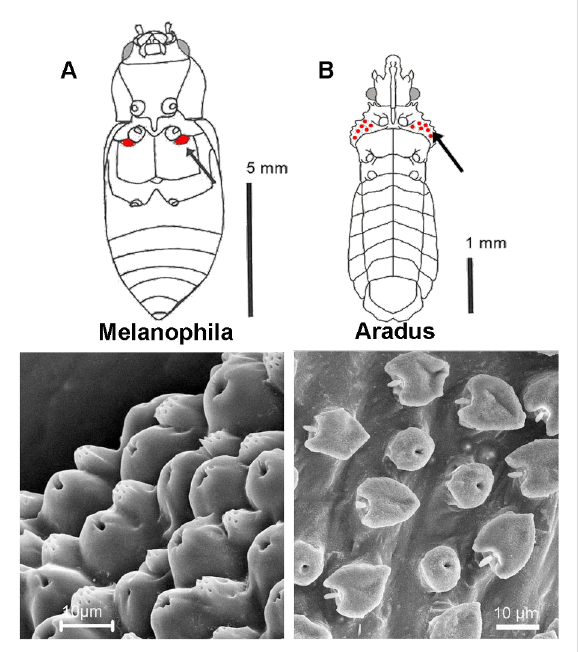
Figure 1: Infrared receptors in Melanophila beetles ( A ) and pyrophilous bug species of the genus Aradus ( B ). In Melanophila about 70 dome-shaped IR receptors which are accompanied by porous wax glands (shown below) are densely packed at the bottom of a thoracic pit (indicated in red and by the arrow). In Aradus bugs about a dozen IR receptors (indicated in red and shown below) are inter- spersed between mechanosensory bristles on the first thoracic segment (arrow) of the bug.